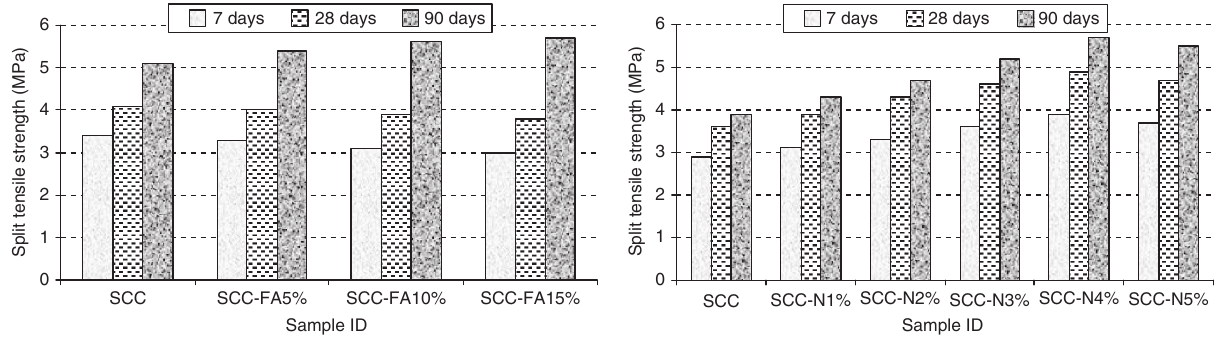
Figure 3 Flexural strength results of SCC-N mixtures.